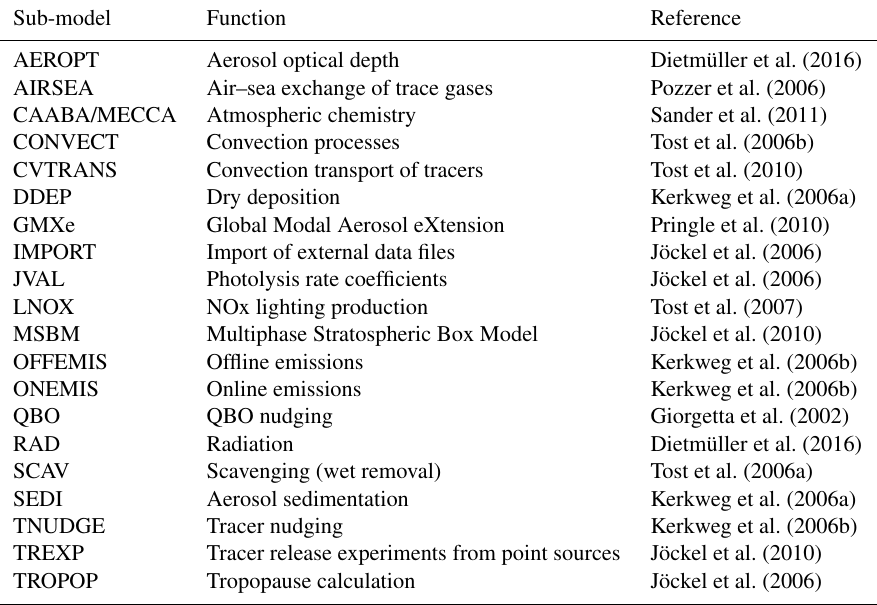
Table A1. List of MESSy sub-models used. References and short description from https://messy-interface.org/messy/submodels/ (last access: 10 January 2023). Parts of the base model copied into MESSy which must always be active are not listed